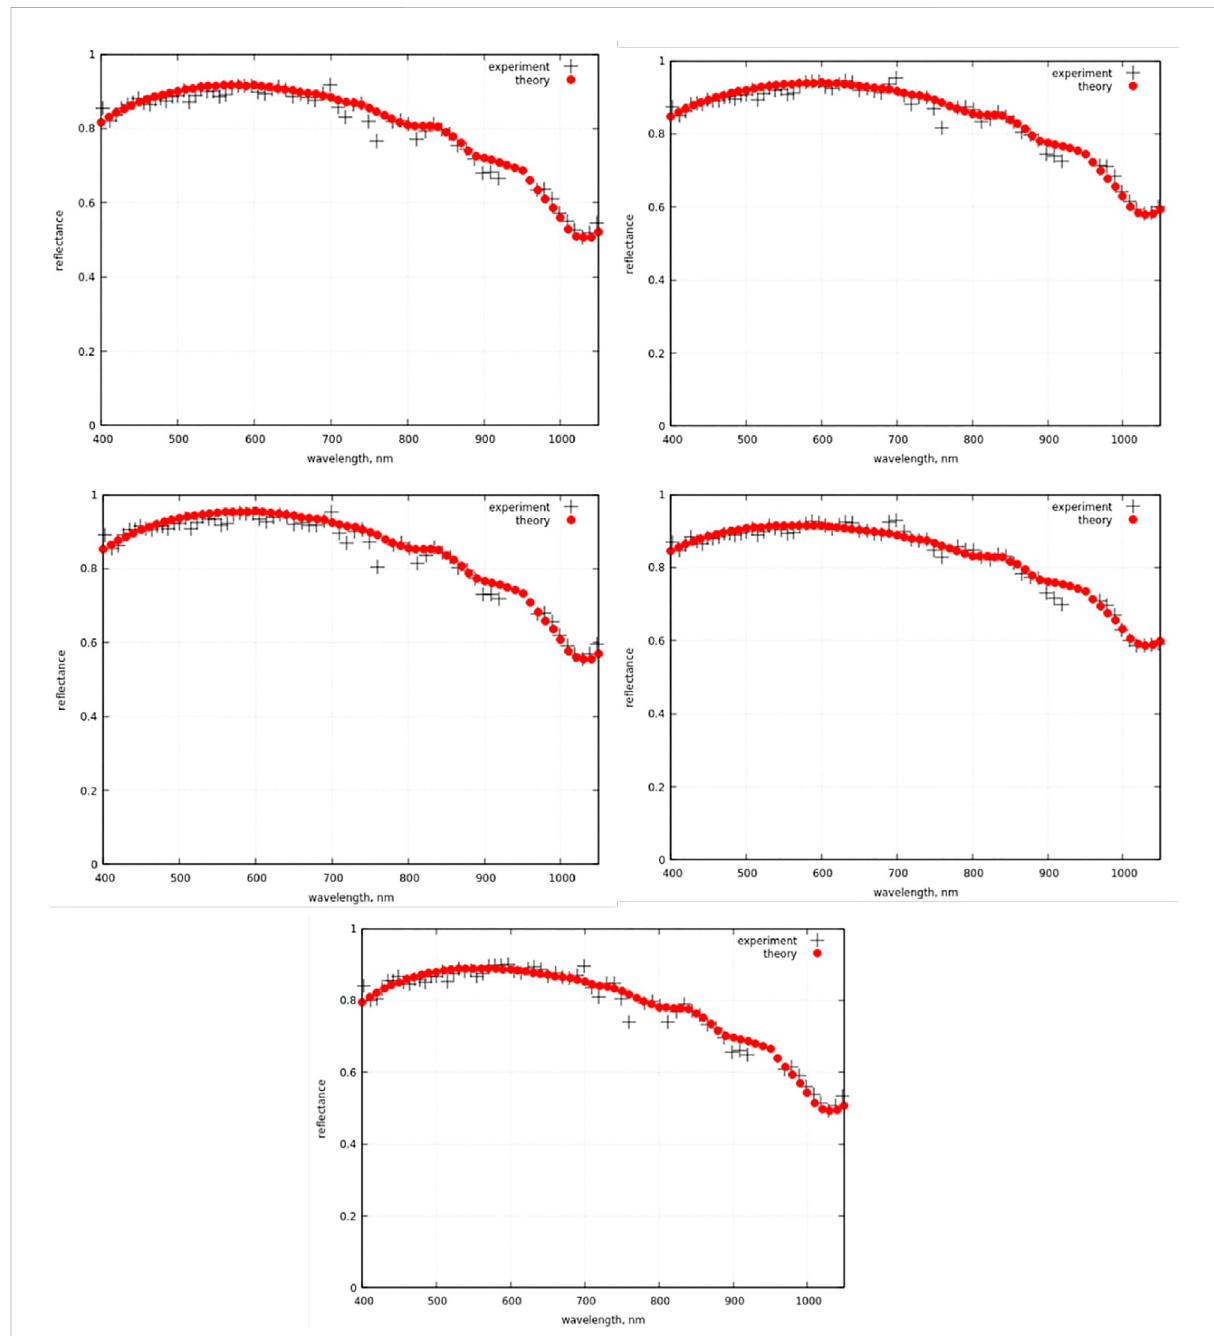
FIGURE 2 Comparison ofsimulatedre fl ectancewithsatellitemeasurementsforthe fi rst fi vecasesshowninTable4.Thesequenceofplotscoincideswith the sequence of lines in Table